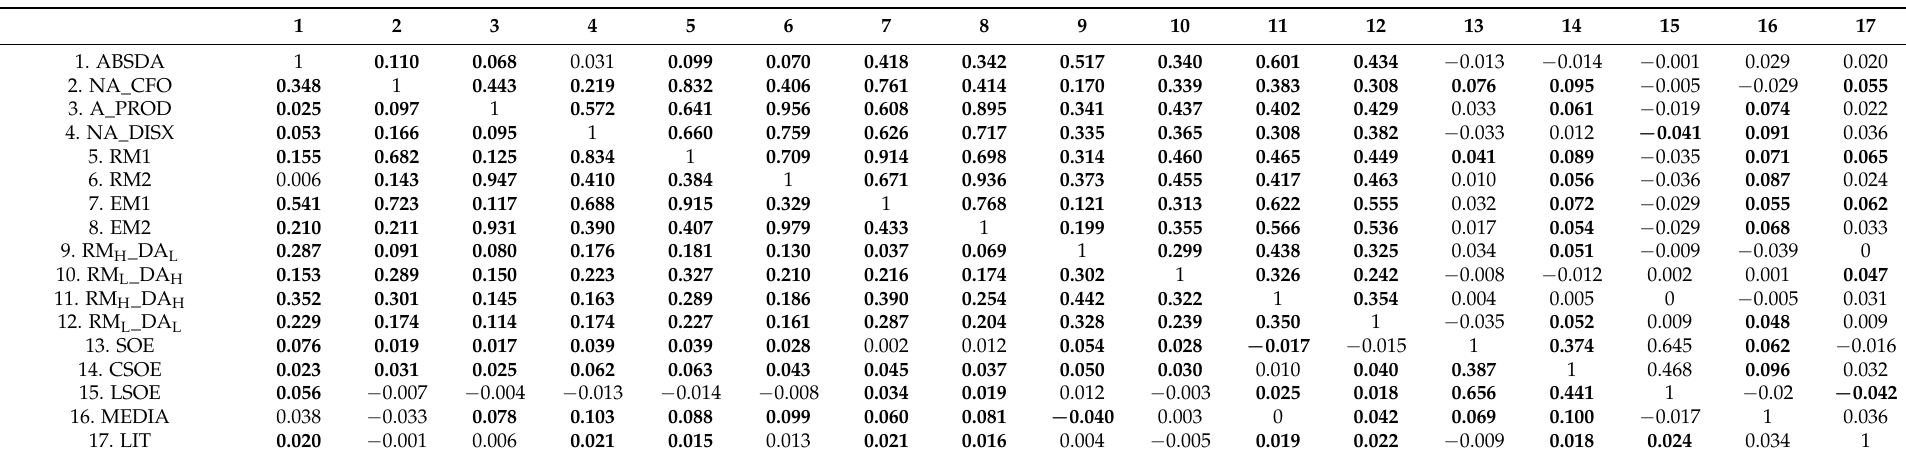
Table 5. Correlation